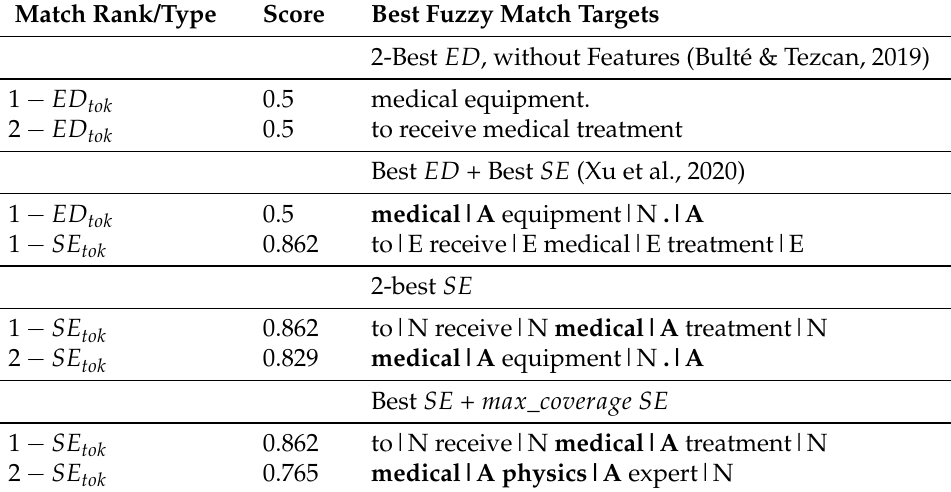
Table 2. Adding feature labels to best fuzzy match targets retrieved for the Hungarian input source ‘orvosi fizikus szakért˝ok .’ (EN: ‘medical physics experts .’). The feature labels “ A ” and “ N ” indicate target tokens that are aligned/not aligned to tokens in the input source. Label “ E ” is a dummy feature used for correct formatting. Target tokens that are aligned to the input source through features are marked in